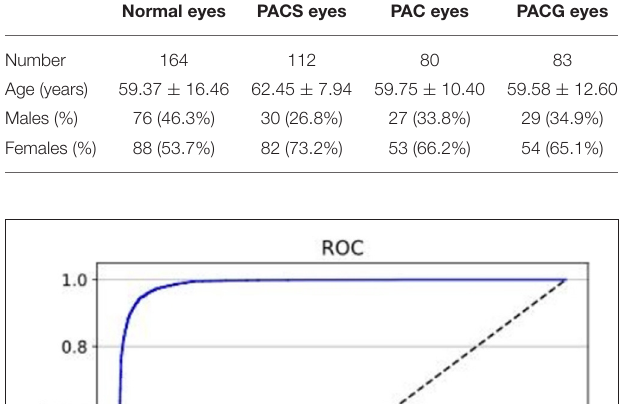
FIGURE 7 | The performance of test set 1 for the test classifier achieved an AUC of 0.973 with a sensitivity of 93.4% and specificity of 94.6%.